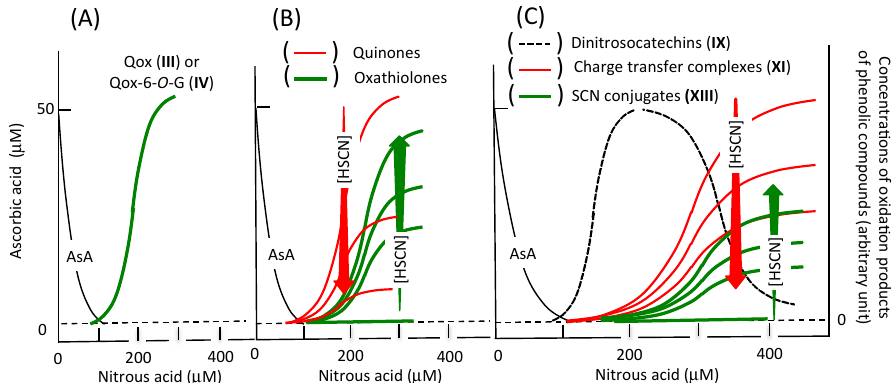
Figure 4. Formation of oxidation products of phenolic compounds as a function of nitrous acid concentration. Initial concentration of ascorbic acid (AsA) is postulated to be 50 μ M and the concentration of nitrous acid is postulated to increase up to 400 μ M. ( A ) quercetin or quercetin 7- O -glucoside; ( B ) caffeic acid, chlorogenic acid, or rutin; ( C ) (+)-catechin or (–)-epicatechin. Red downward and green upward arrows indicate increase in thiocyanate concentration. Its increase suppresses the formation of quinones and charge transfer complexes (red curves) and enhances the formation of oxathiolones and SCN conjugates (green curves).